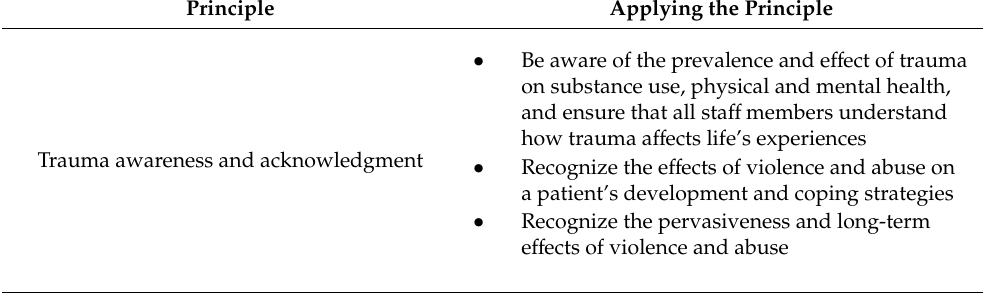
Table 1. Principles of trauma-informed programs and care (Adapted from Purkey et al.